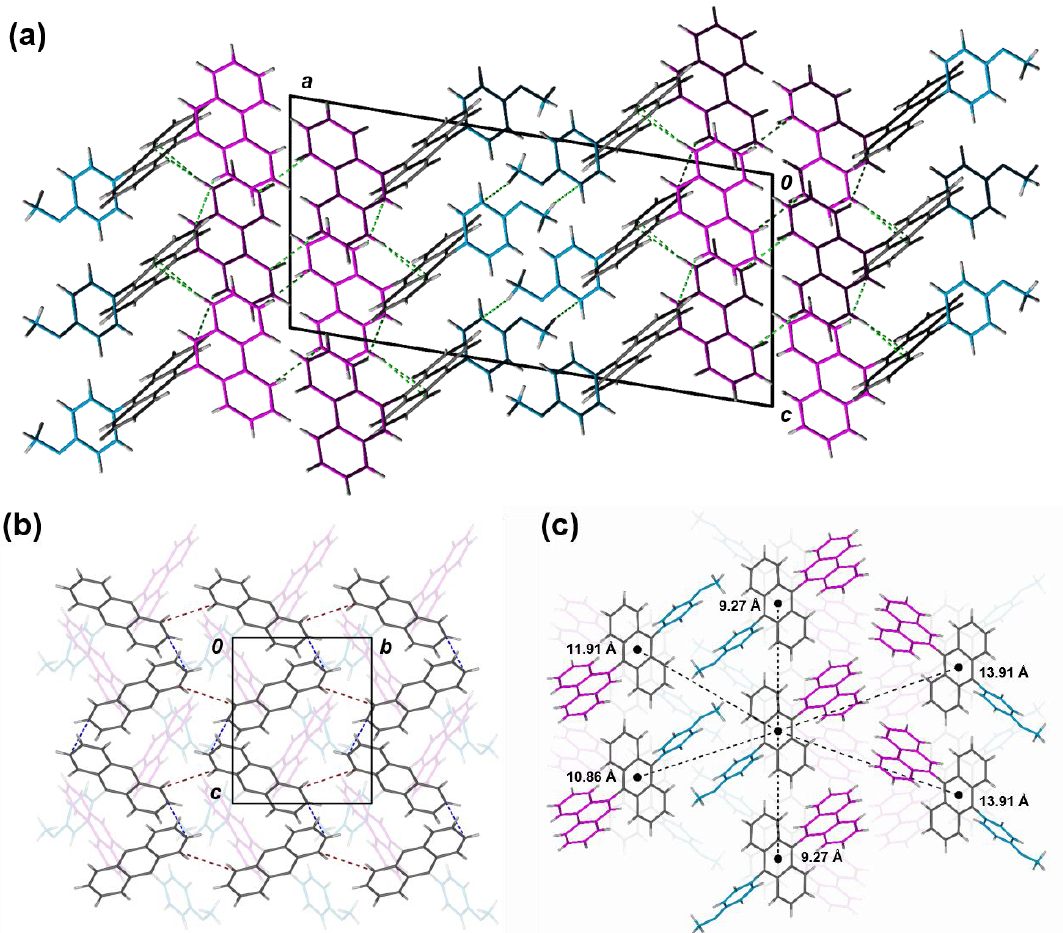
Figure 5. Slipped π -stacks of 2d viewed along the a -direction (a) and b -direction (b). C–H ··· π interactions between pendent substituents (R 1 = magenta; R 2 = blue) and anthracene cores are shown in green, while π – π contacts between anthracene units are shown in blue (intrastack) and red (interstack). ( c ) Distances between the centroids of neighboring molecules are illustrated between nearest π -stacks along the c -direction.